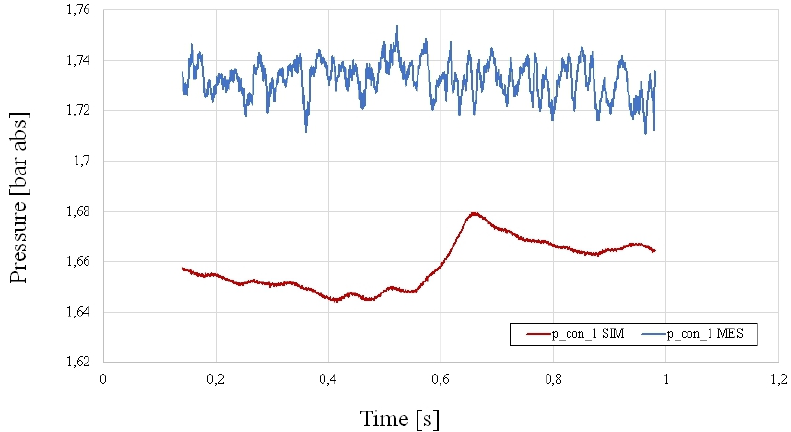
Figure 23. Comparison of simulation (SIM) and measured (MES) pressure at the draft tube conus at